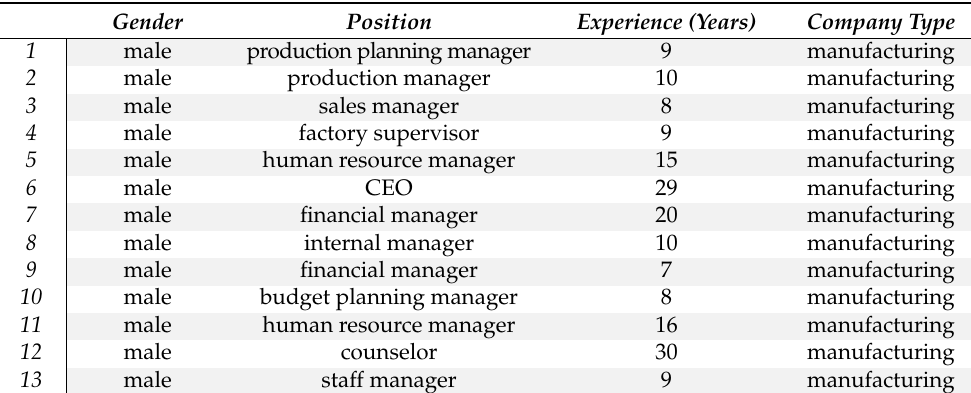
Table 2. Information regarding the decision-makers involved.